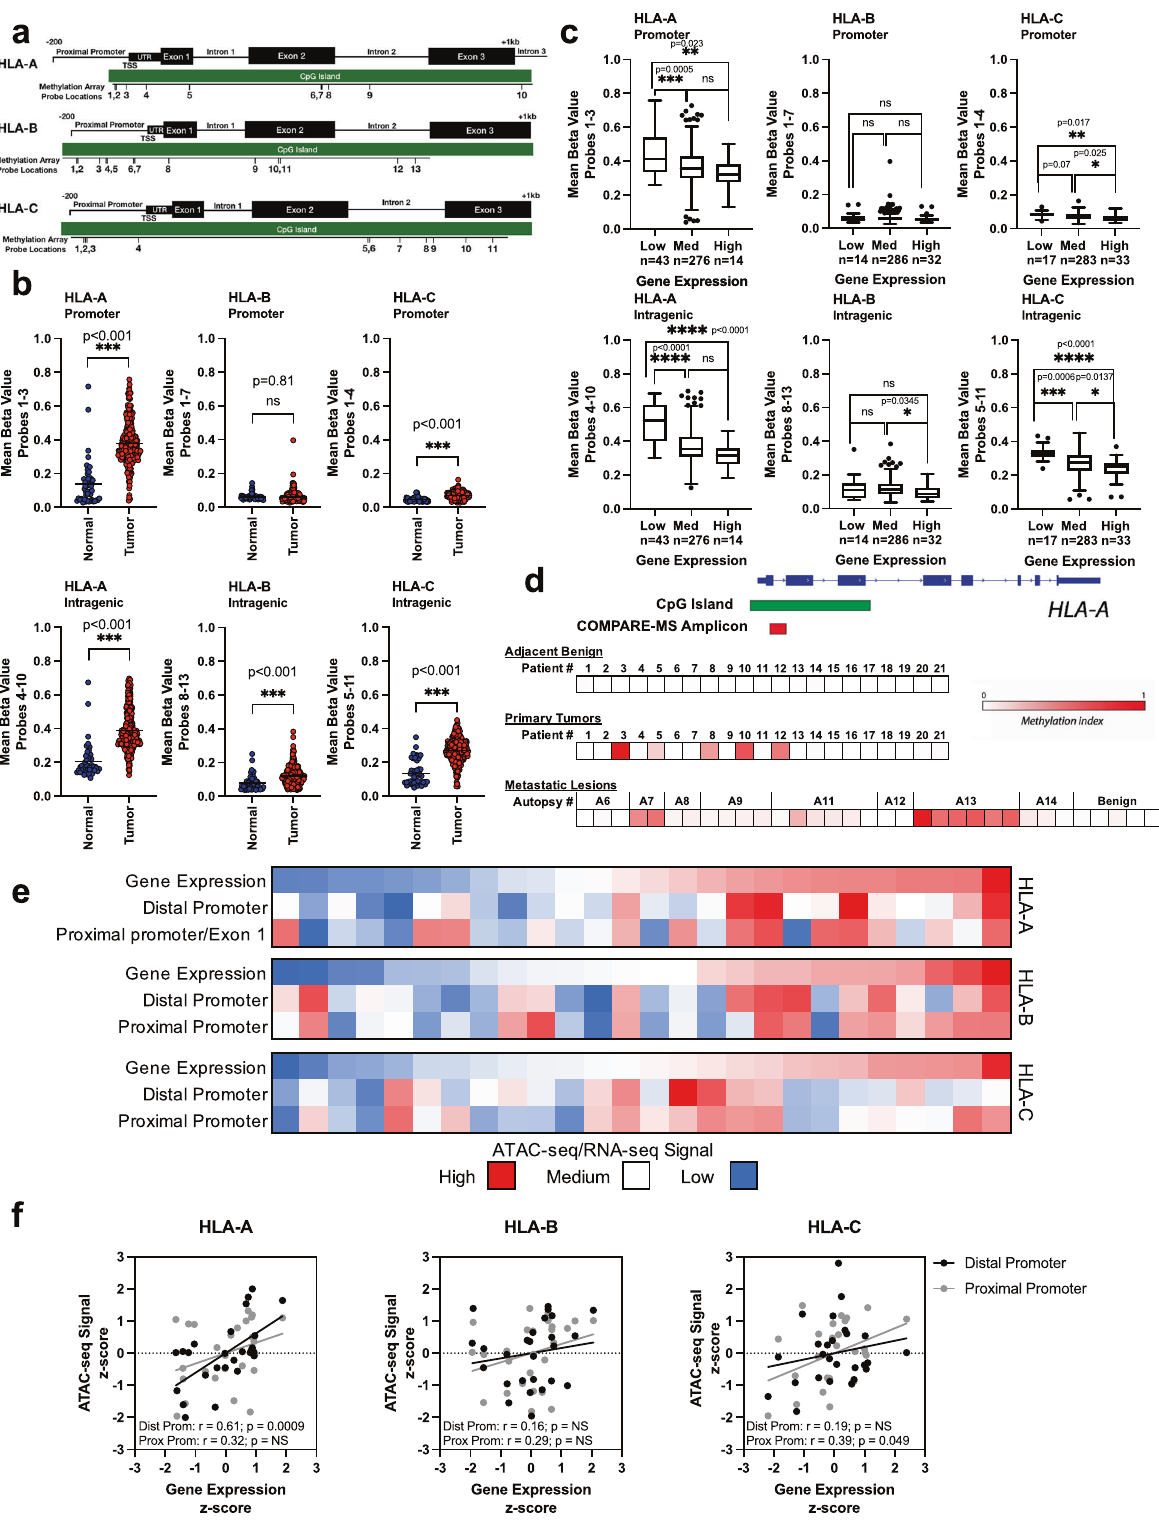
qPCR (Fig. 3d). Primers were designed to target regions of the HLA-I genes that were identi fi ed as being differentially methy- lated in patient samples, including the distal and proximal pro- moter as well as two intragenic regions (IG) near Exon1/Intron1 (IG 1) and Exon2/Intron2 (IG 2) (Fig. 3e). LAPC4 had the highest level of methylation in all three HLA-I genes. PC3 and LNCaP also had increased methylation in certain gene regions compared